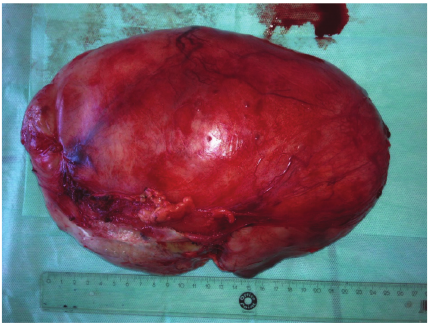
Figure 3: Resected